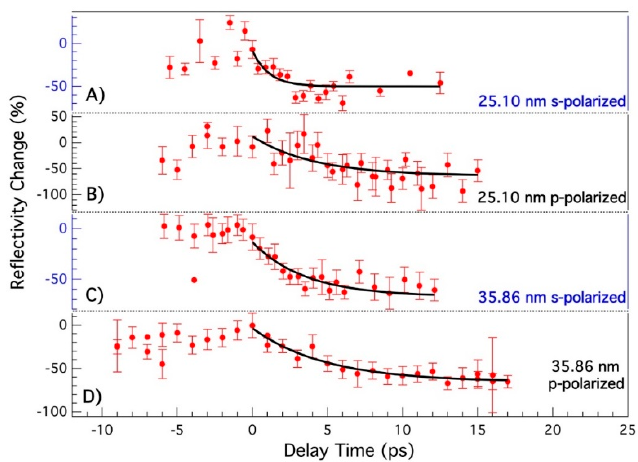
Figure 1. Reflectivity signal values as a function of delay time for 4 different combinations of wavelength and polarization, i.e.,: ( A ) 25.10 nm and s-polarization, ( B ) 25.10 nm and p-polarization, ( C ) 35.86 nm and s-polarization, ( D ) 35.86 nm and p-polarization. The solid blackline corresponds to the fit, while the red dots correspond to the experimentally measured signal.